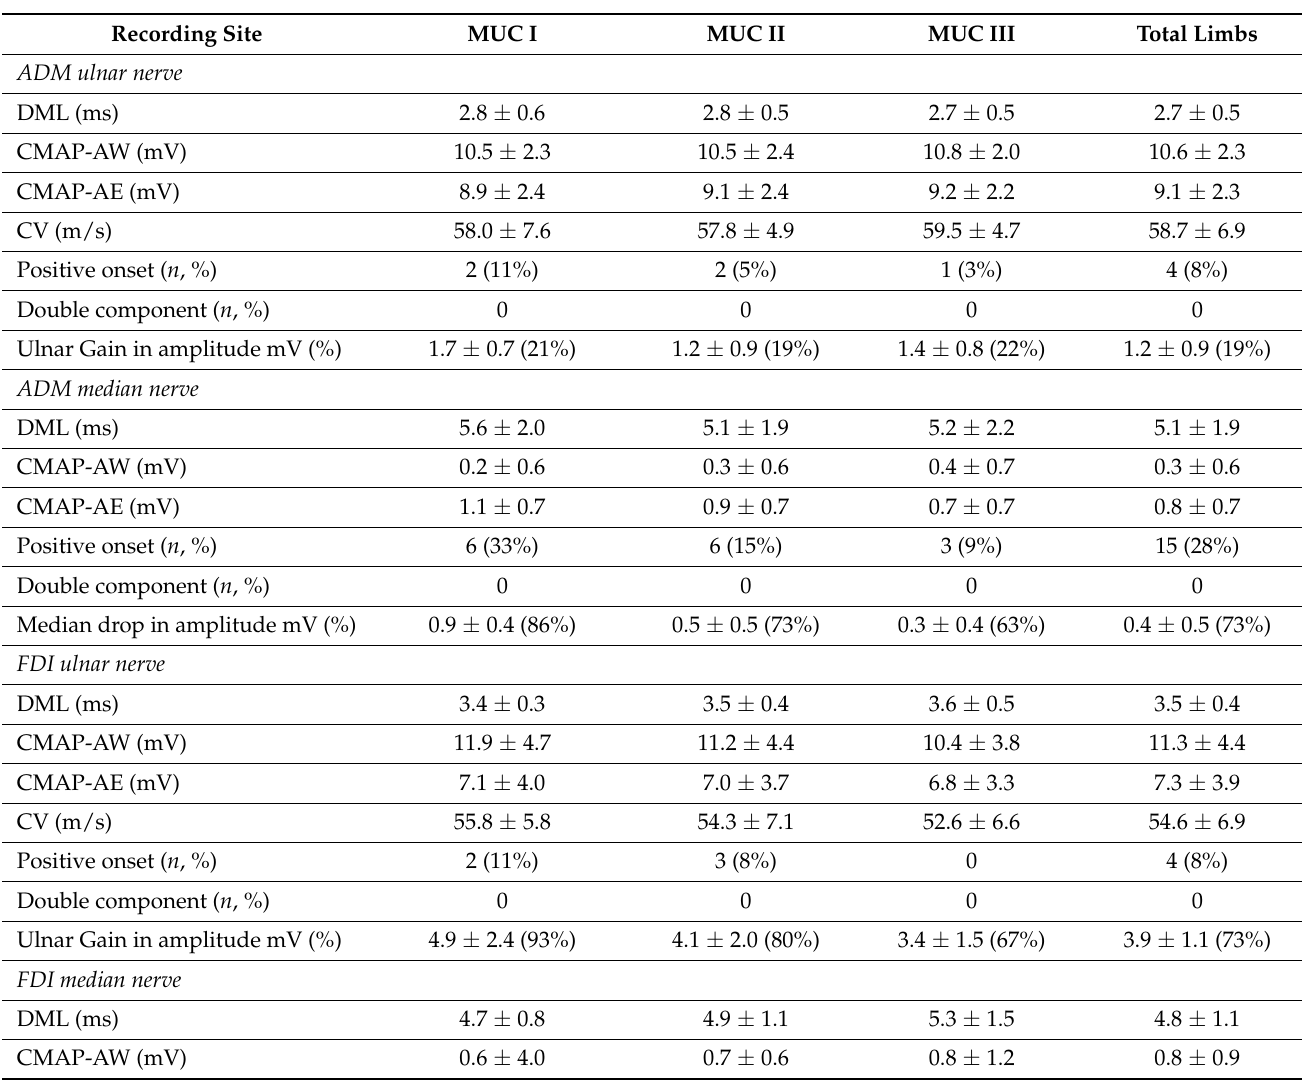
Table 4. Nerve conduction studies in patients with carpal tunnel syndrome and median-to-ulnar communicating branch. Values are expressed as means with standard deviations or